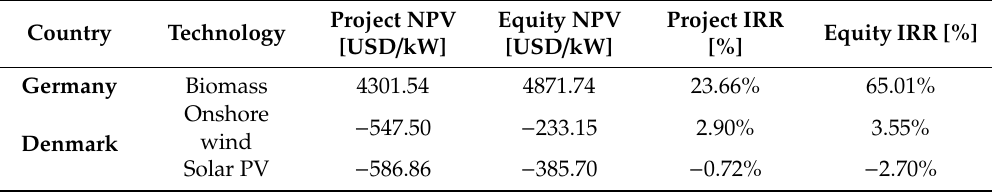
Table 4. Project and equity NPV and IRR for the German biomass and the Danish solar PV and onshore wind auctions under the base case assumptions in Table 3. Source: